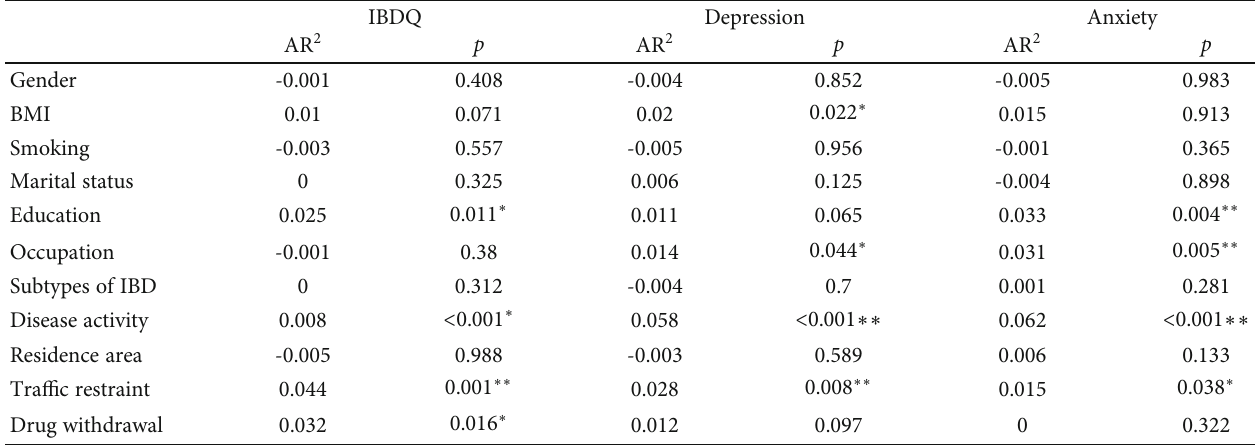
Table 4: The multiple-factor analysis of the quality of life, depression, and anxiety.